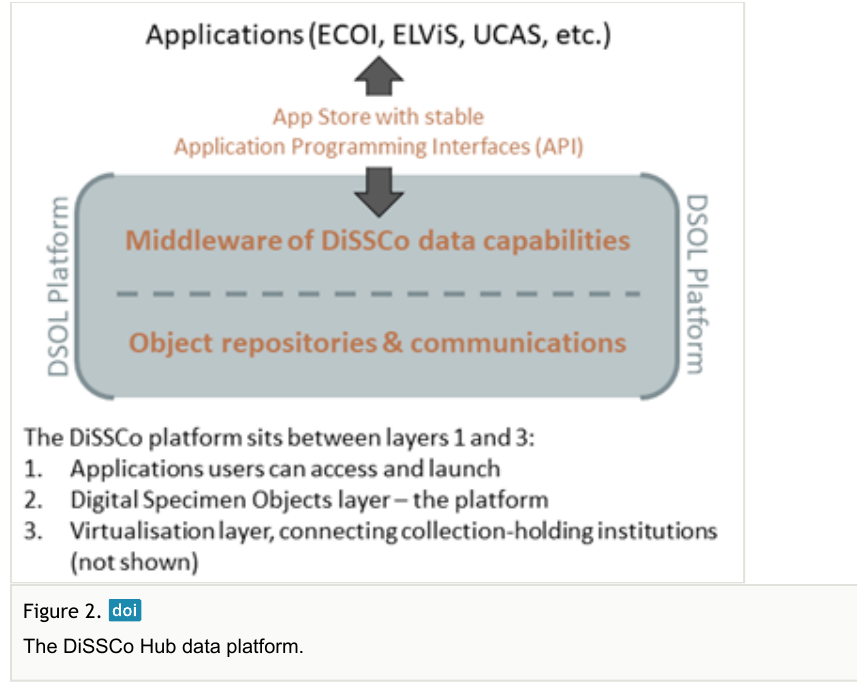
Figure 2. The DiSSCo Hub data